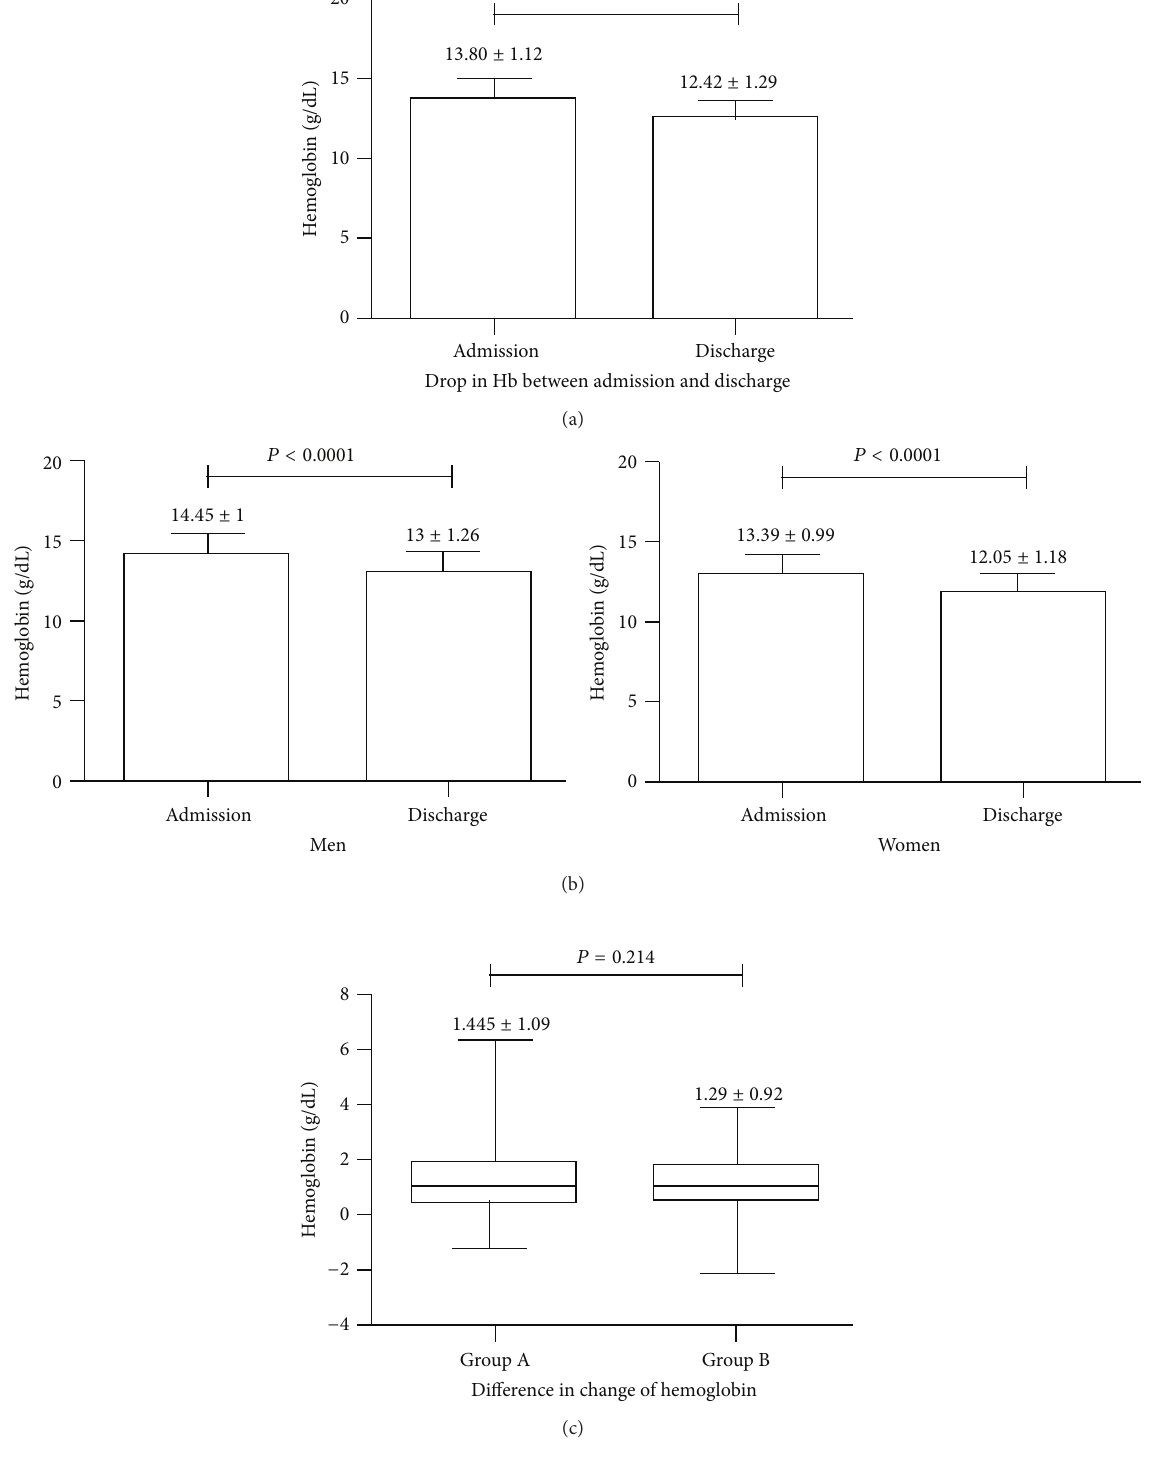
Figure2:Differenceinchangeandreductionofhemoglobinbeforeandaftersmallertubeimplementation.Hemoglobindroppedsignificantly between admission and discharge (Figure 2(a)). The drop in hemoglobin between admission and discharge by sex categorization. Both men and women dropped their hemoglobin significantly (Figure 2(b)). Implementation of smaller tube did not significantly reduce the change in hemoglobin (Figure